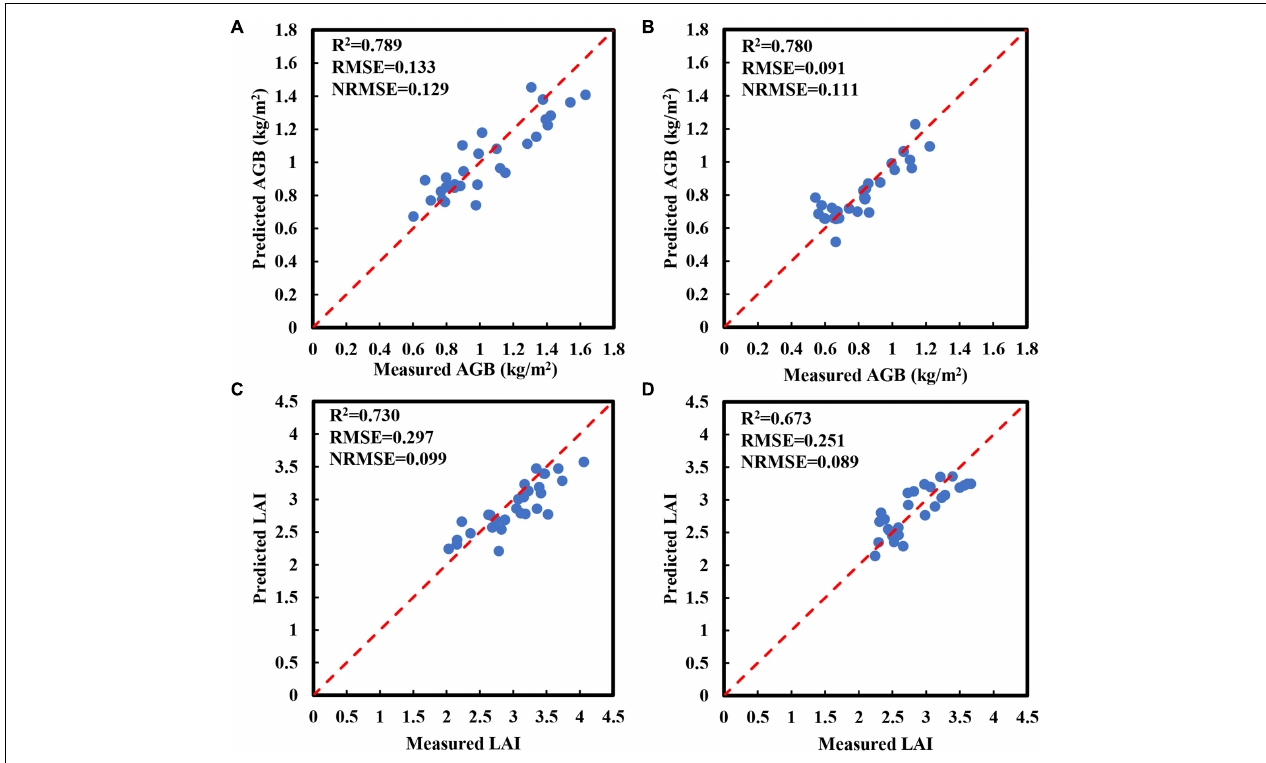
FIGURE 5 | Relationship between the predicted and measured AGB and LAI obtained by using the SMLR models within the test dataset. (A) AGB of red bean; (B) AGB of mung bean; (C) LAI of red bean; (D) LAI of mung bean. The red line is a 1:1